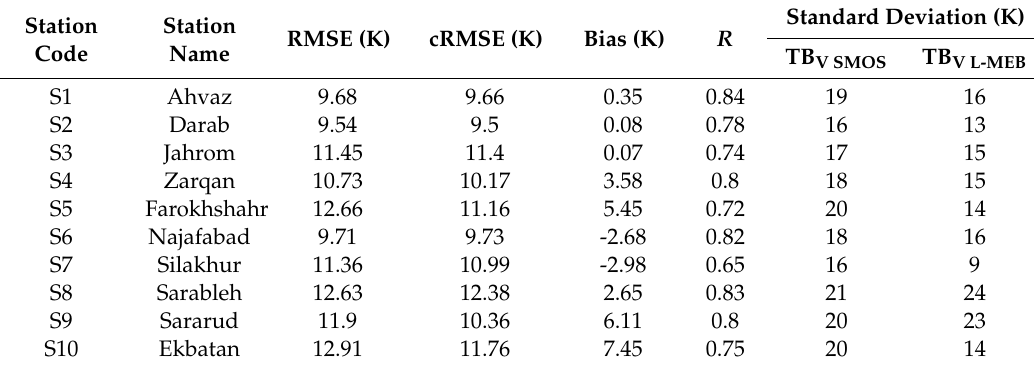
Table 4. Statistical results of the TB V SMOS compared to TB V L-MEB at the stations. Station